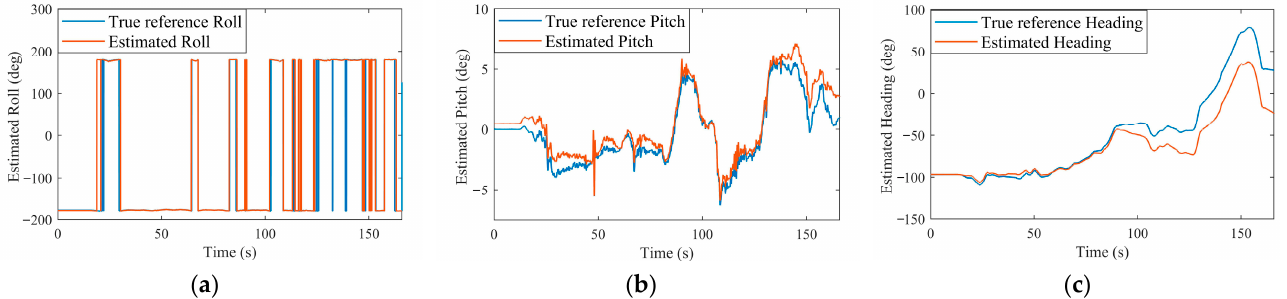
Figure 10. The estimated and reference orientation of the ground vehicle for ( a ) roll angle, ( b ) pitch angle, and ( c ) heading.